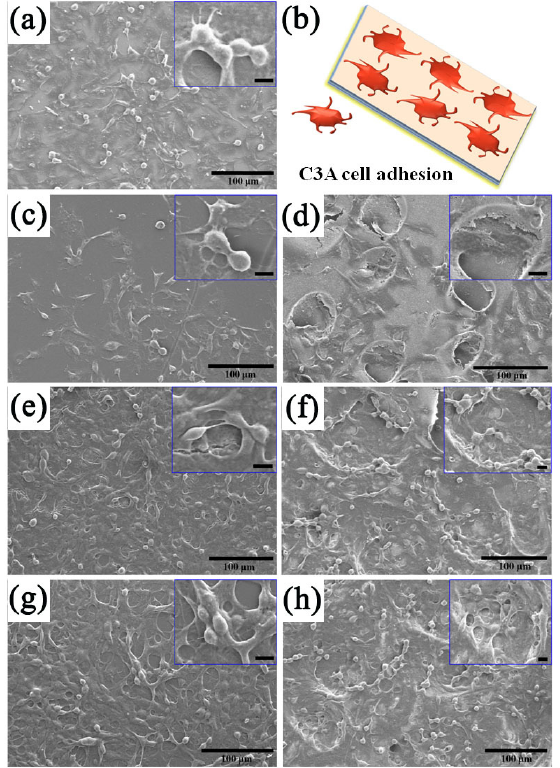
Figure 8. SEM images of C3A cell adhesion on glass ( a ), iPES (( c ), Dense layer; ( d ), Support layer), iPES/PDA ( e ), Dense layer; ( f ), Support layer), and iPES/PDA/Lys (( g ), Dense layer; ( h ), Support layer). ( b ) Schematic diagram of C3A cells adhesion on the surface of the membrane.